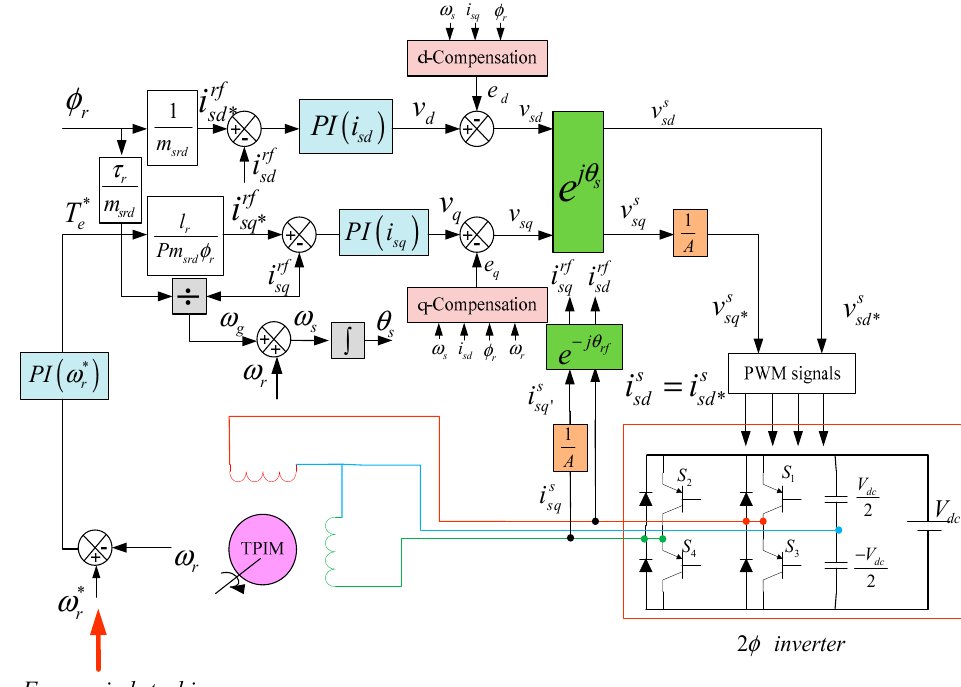
Figure 10. Vector-controlled TPIM drive structure using IRFOC.